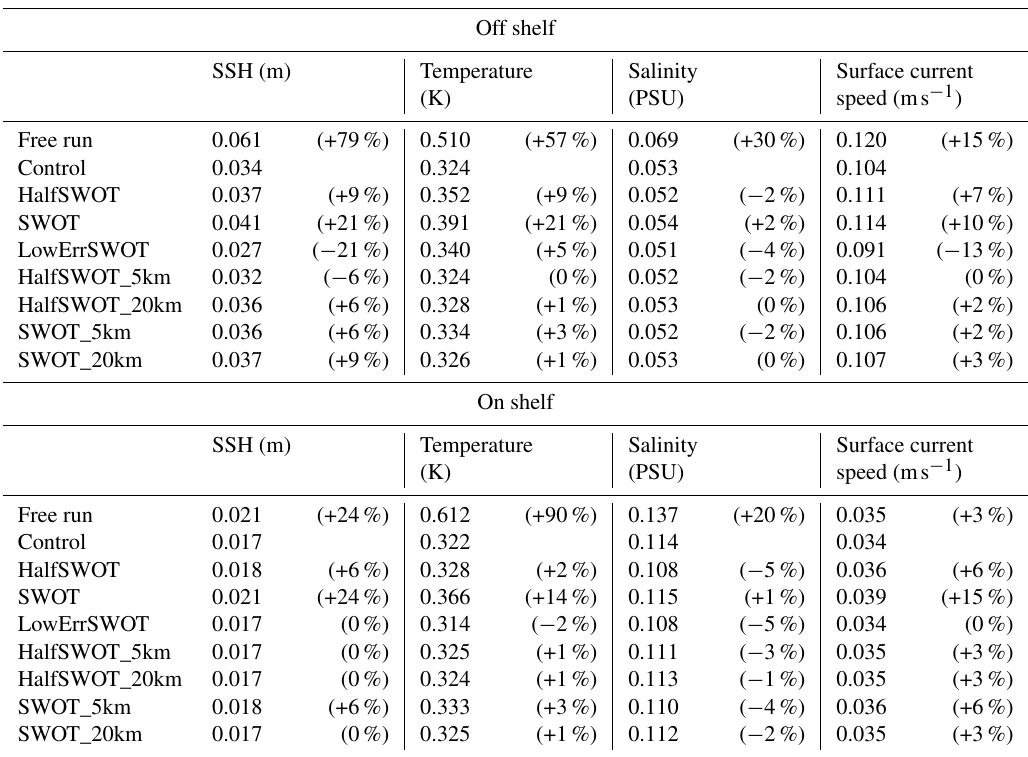
Table 3. SSH, surface current and total column temperature and salinity RMSE (calculated at all model grid points) for the on- and off-shelf regions from each experiment. The percentage change in RMSE compared to the control run is shown in